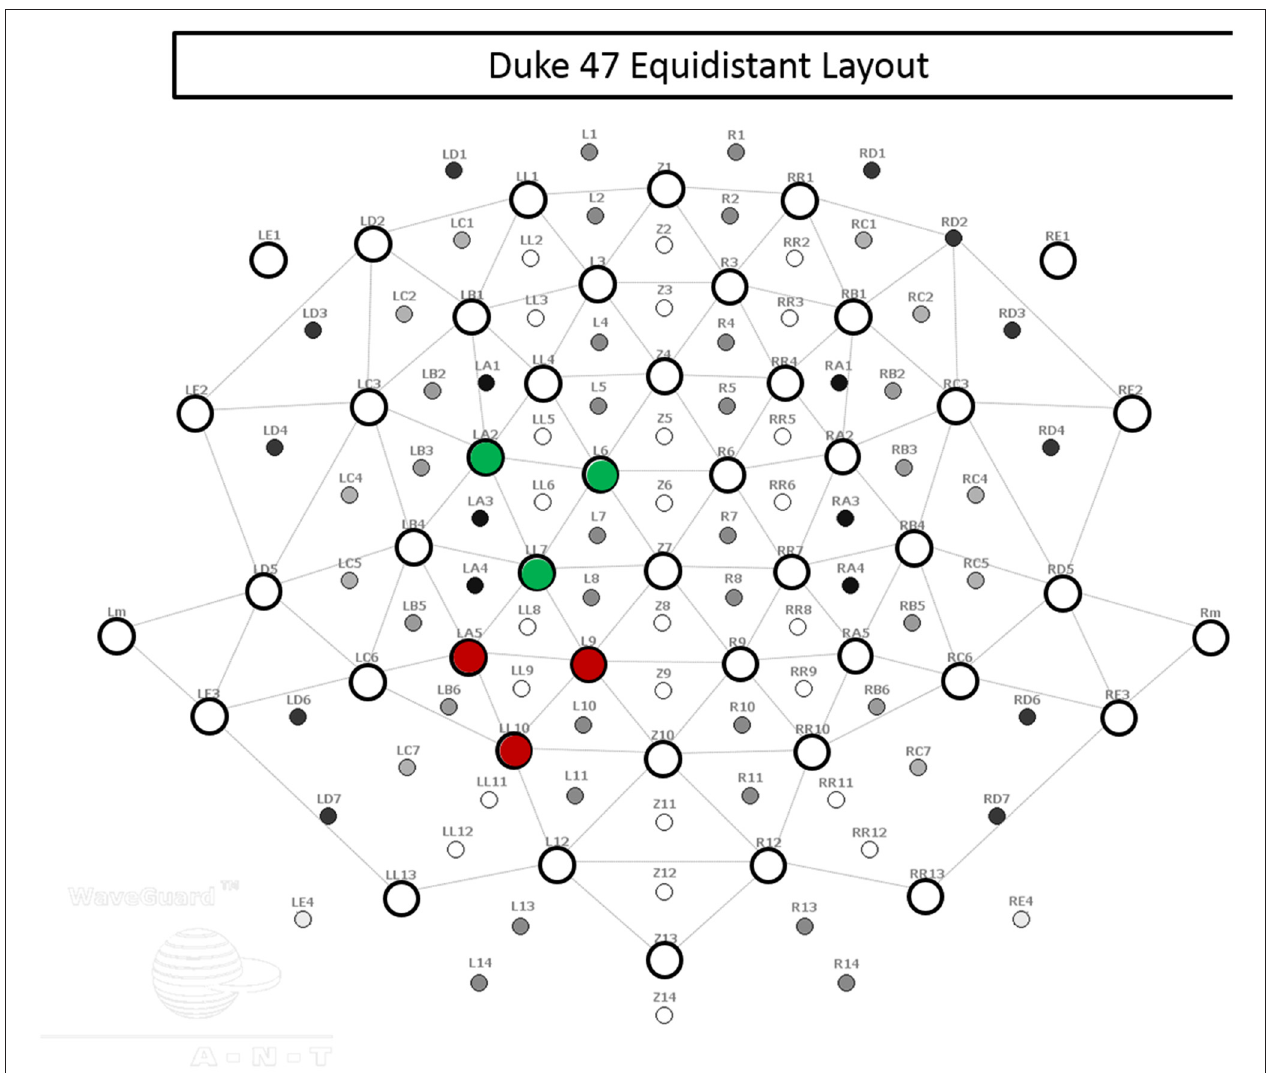
FIGURE 2 | Electrode layout. The 47 electrodes used in recording are represented by open circles. Electrodes within the left central regions of interest (ROI) are indicated in green, and electrodes within the left posterior ROI are indicated in red.